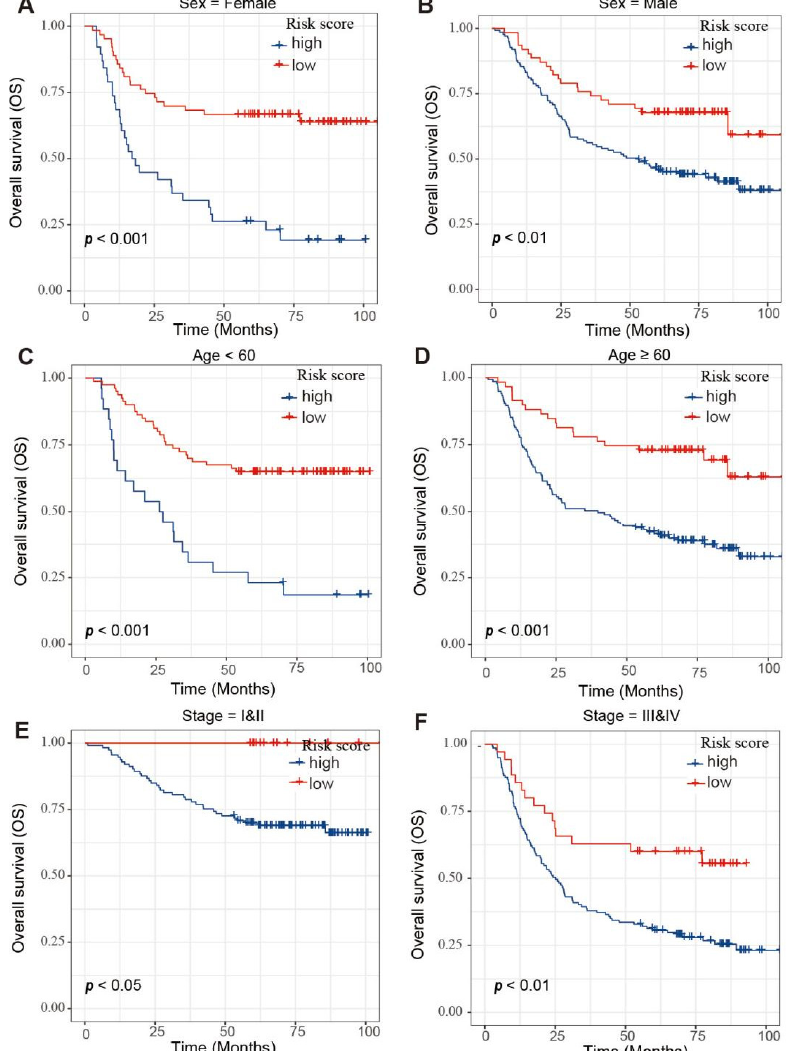
Figure 8. Survival analysis of GC patients in different subgroups. ( A – B ) Survival analysis of the GC patients with ( A ) sex = female and ( B ) GC patients with sex = male subgroup. ( C – D ) Survival analysis of the GC patients with age < 60 ( C ) and GC patients with age ≥ 60 ( D ) subgroup. ( E – F ) Survival analysis of the GC patients with stage = I & II ( E ) and GC patients with stage = III & IV ( F ) subgroup. To demonstrate the reliability of the risk score model, the TCGA database was used as the verification dataset (Figure 9). GC patients were divided into the low-and high-risk group, respectively. GC patients with high-risk scores had a worse OS compared to the low-risk score group, indicating that the model has excellent accuracy.